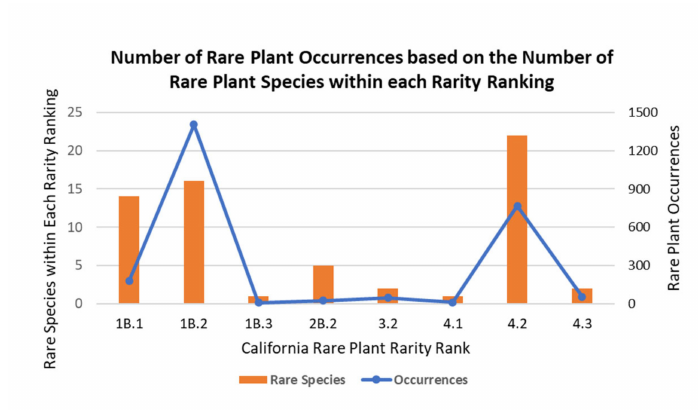
Figure 6. Number of rare plant occurrences within each CRPR ranking, compared to the total number of rare plant species that fall into the CRPR category. Out of the 64 rare species within the NCC reserve, 30 rare species are in rank one with 14 species being extremely threatened. Twenty-two species are in rank